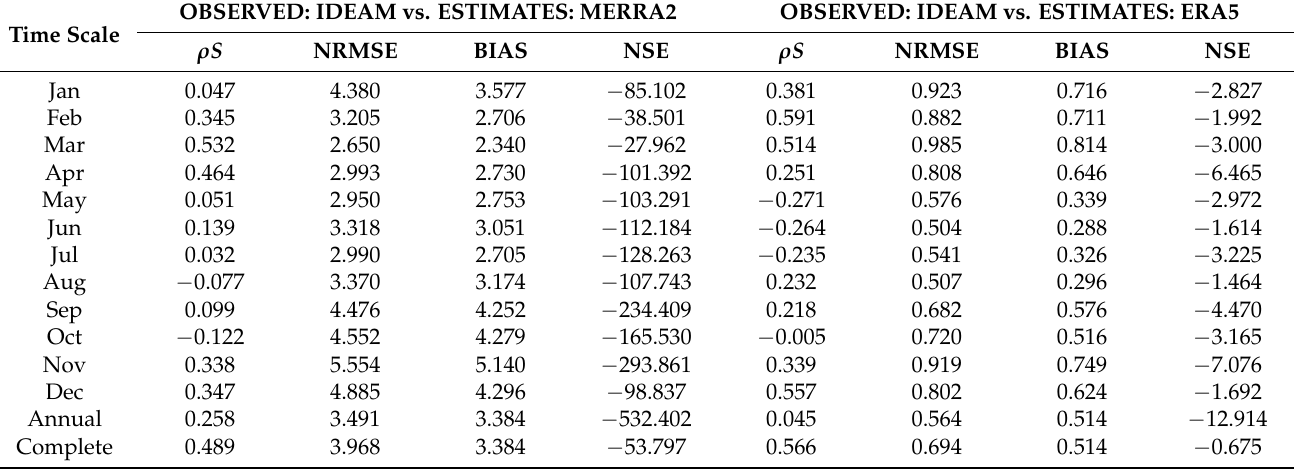
Table 2. Performance results for the tested reanalysis products for average areal rainfall estimations in the Upper Sin ú River basin for 1985–2019. Time